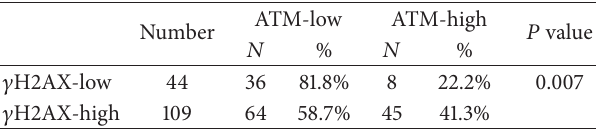
Table 2: Correlation between ATM and 𝛾 H2AX in thyroid